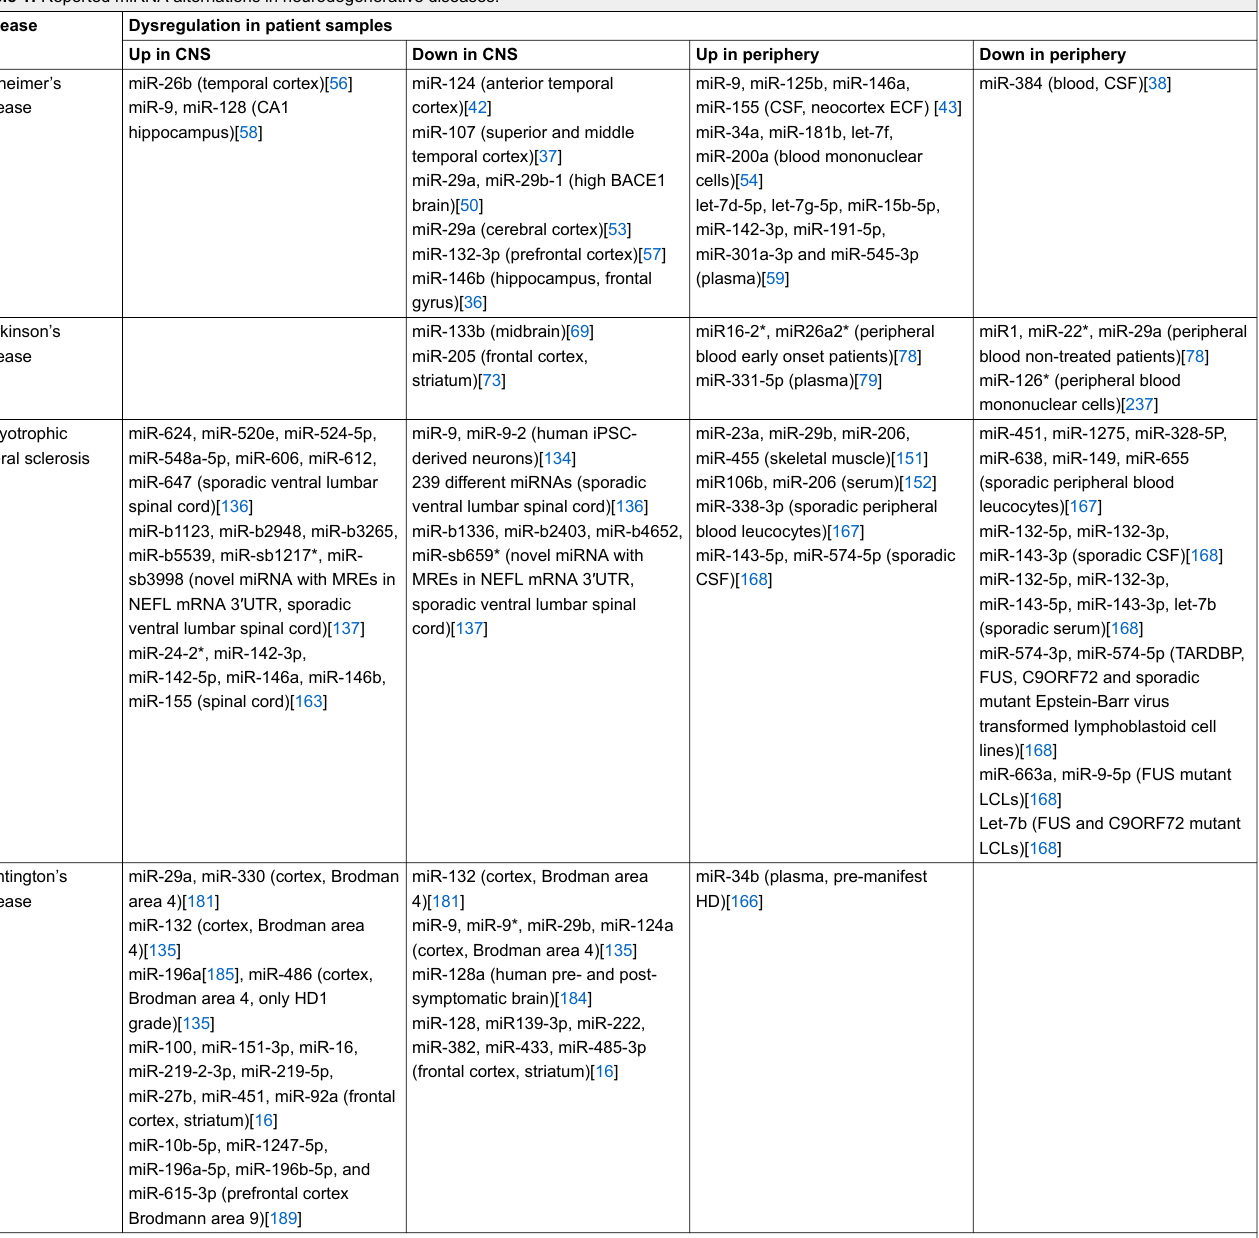
Table 1: Reported miRNA alternations in neurodegenerative diseases. Dysregulation in patient